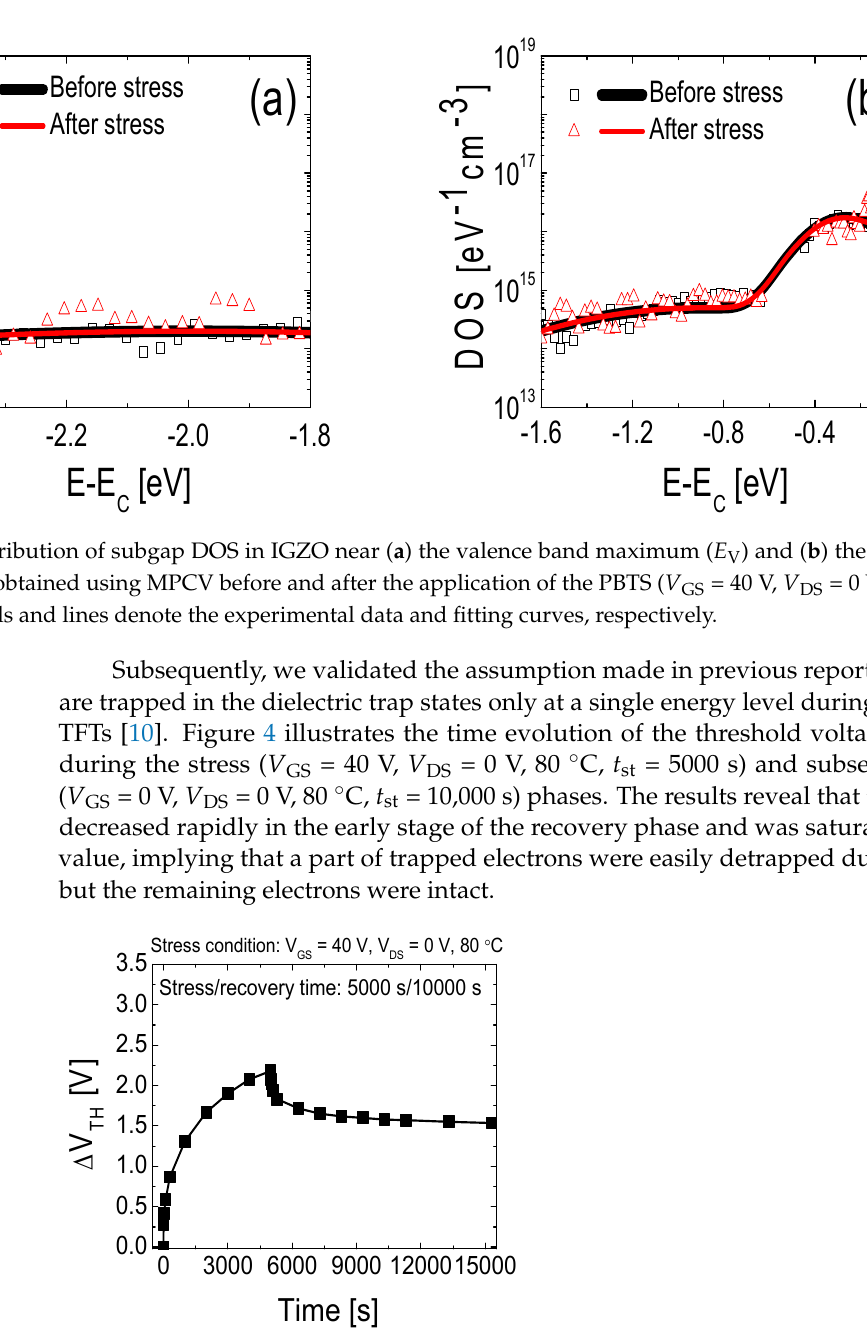
Figure 4. Time evolution of Δ V TH during the stress ( V GS = 40 V, V DS = 0 V, 80 °C, t st = 5000 s) and subsequent recovery ( V GS = 0 V, V DS = 0 V, 80 °C, t st = 10,000 s) phases. Figure 5a shows the time evolution of Δ V TH at different stress/recovery time pairs, and Figure 5b shows the time evolution of the PBTS ‐ induced Δ V TH by both the recoverable and non ‐ recoverable trapped electrons, obtained by applying the stress ‐ time ‐ divided measurement technique to Figure 5a. Figure 5b shows that the time evolution of both Δ V TH